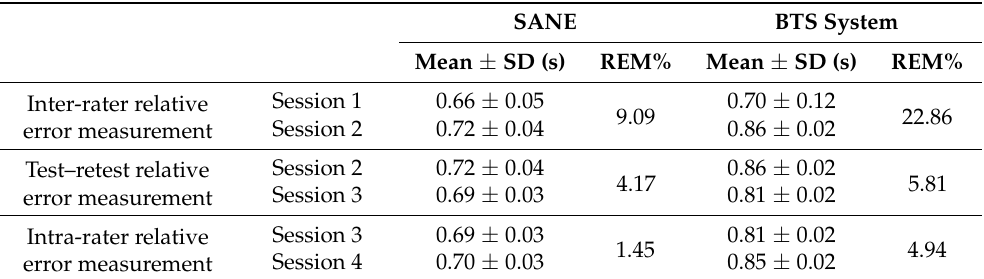
Table 5. Results for gait step